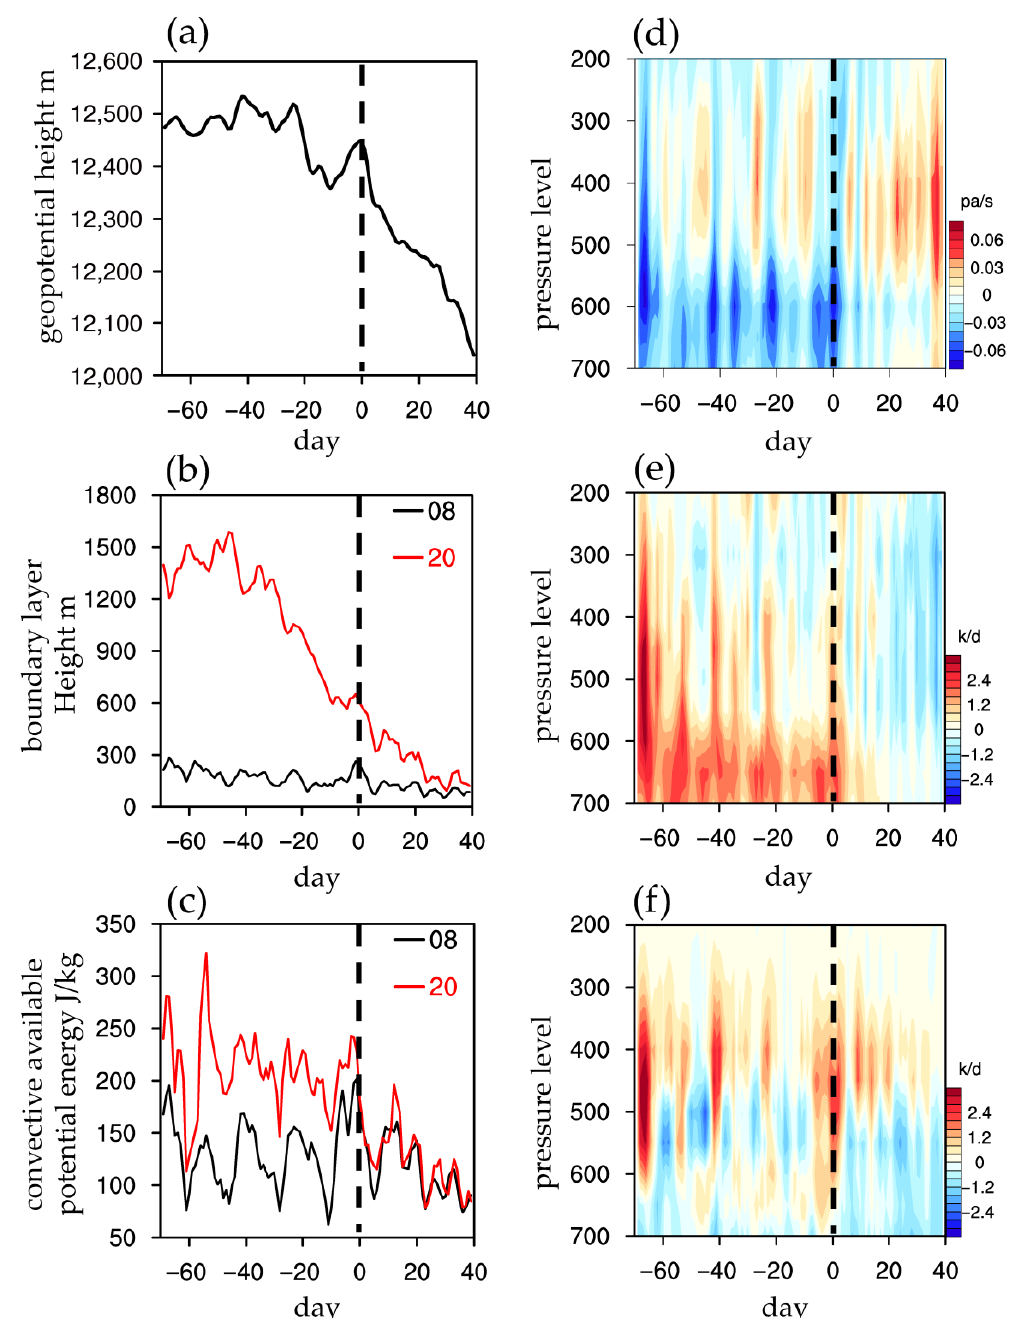
Figure 4. Daily composite analyses for June–October (2010–2015) from day − 70 to 40 relative to transition date averaged over the domain (white box in Figure 1a) for ( a ) 200 hPa geopotential height (m), composite 20:00 and 08:00 domain averaged ( b ) boundary layer height (m) and ( c ) convective available potential energy (J / kg), ( d ) vertical velocity, ( e ) apparent heat source (Q1, J / kg), and ( f ) apparent moisture sink (Q2, J / kg) at pressure levels. A 3-day running mean was conducted for all panels. The black dashed lines indicate composite transition day.